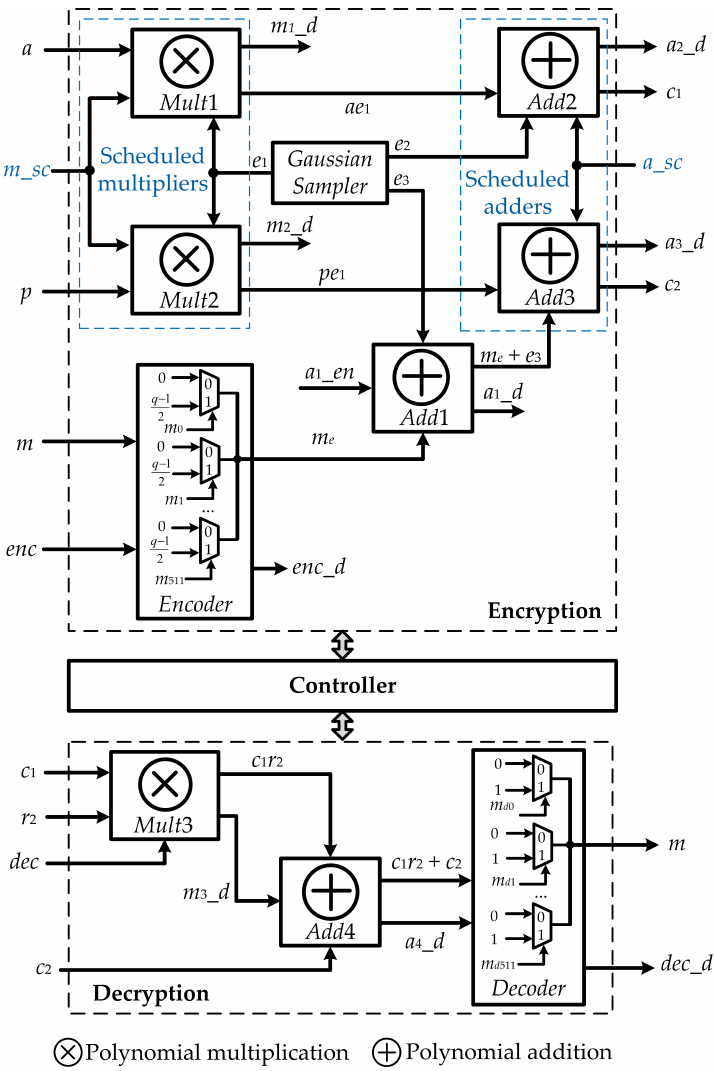
Figure 3. Proposed efficient-scheduling parallel multiplier-based ring-LWE cryptoprocessor